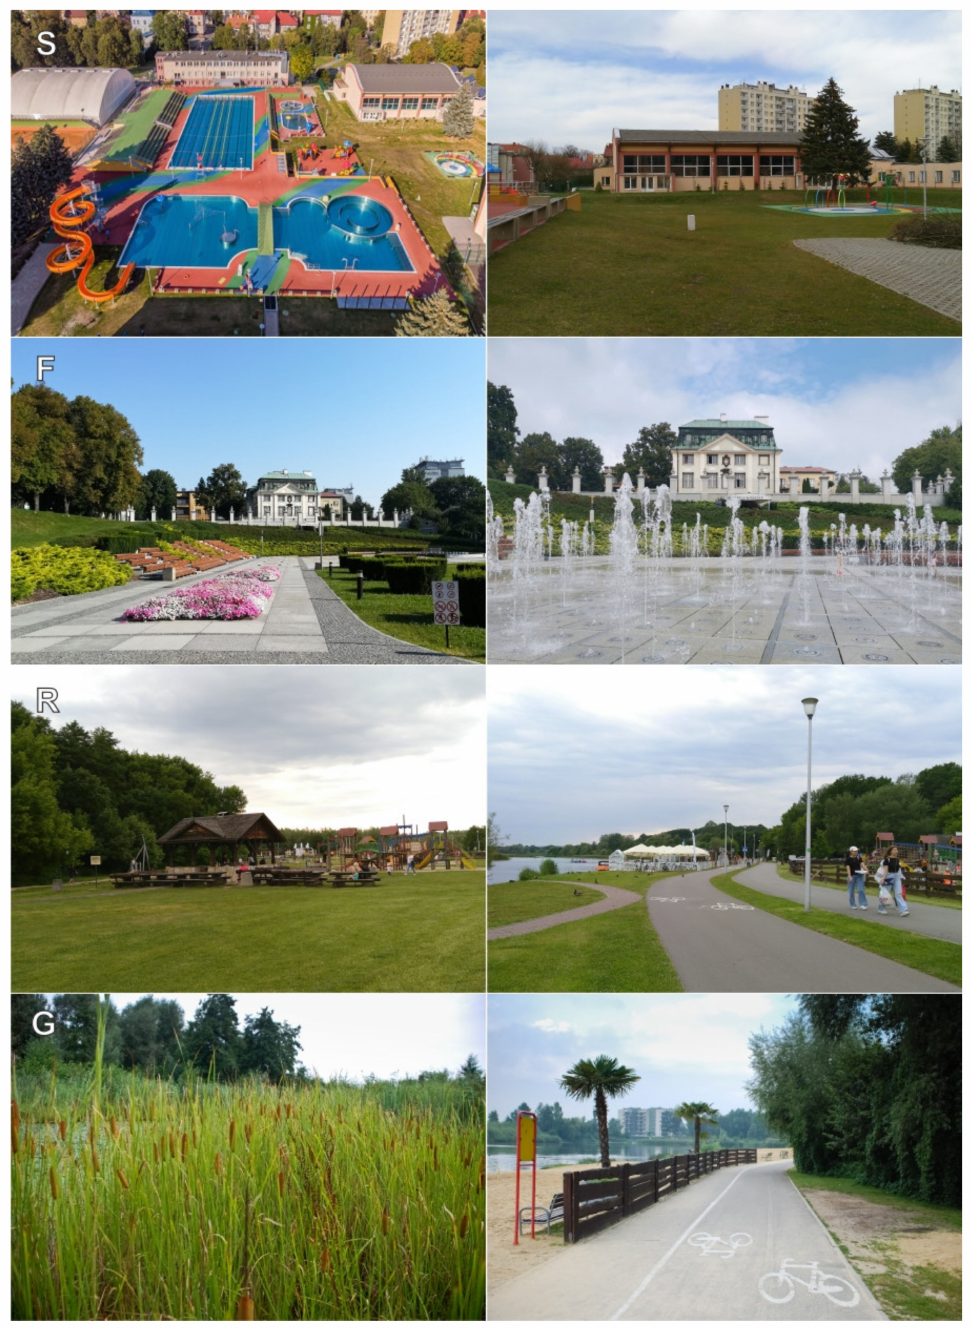
Figure 2. Sites of the study: S—open swimming pools, F—multi-media fountain, R—reservoir, G—gravel pit lake (photo. S left—T. Po´zniak, S right, R—A. ´Cwik; F, G—T. W ó